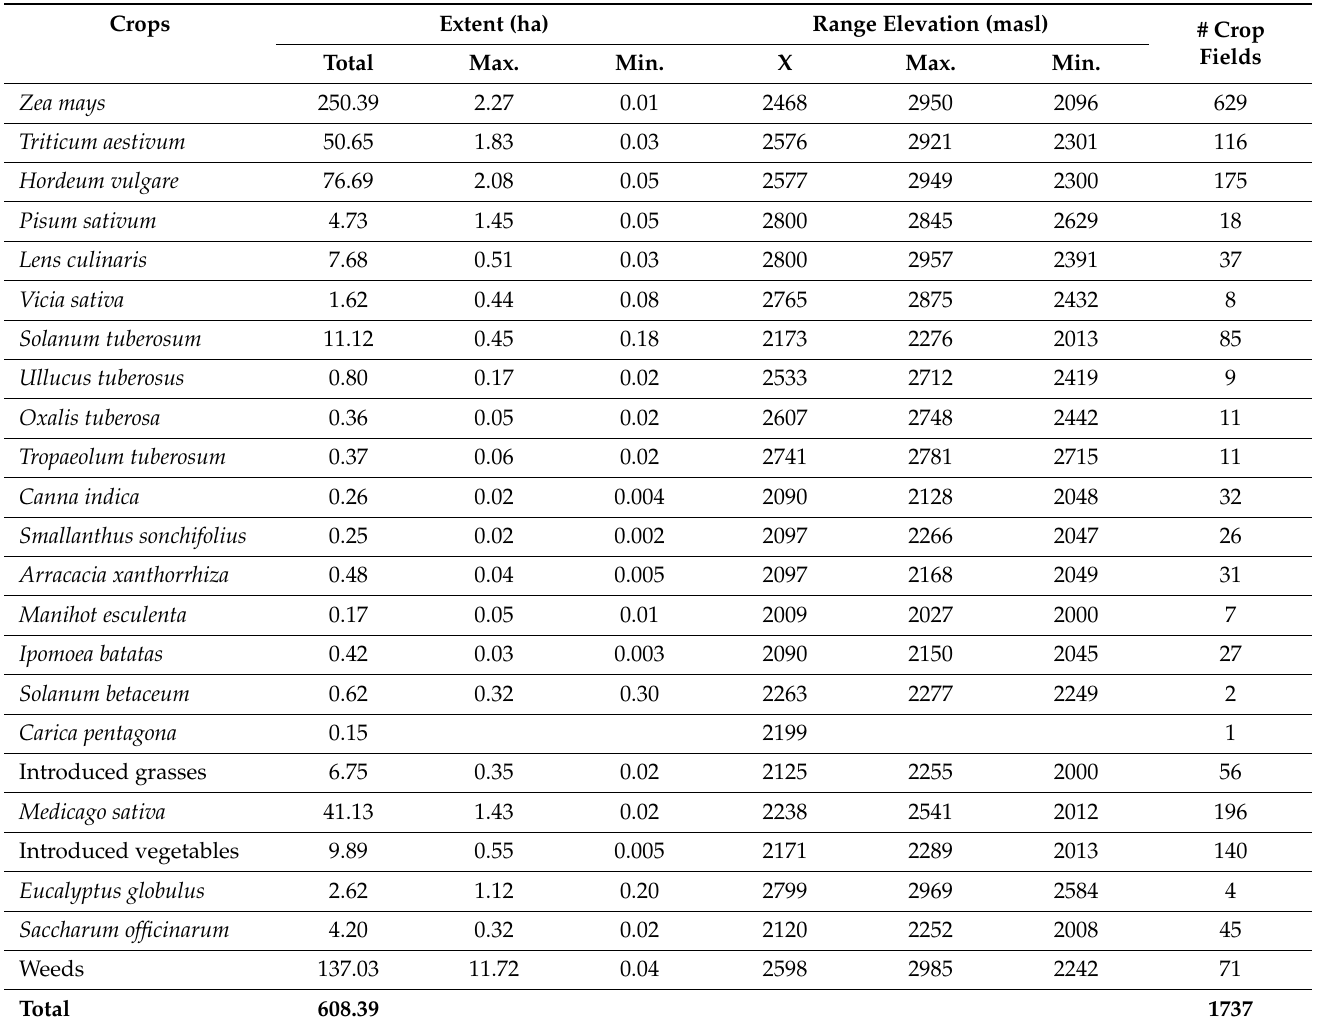
Table 6. Extension, elevation range, and number of crop